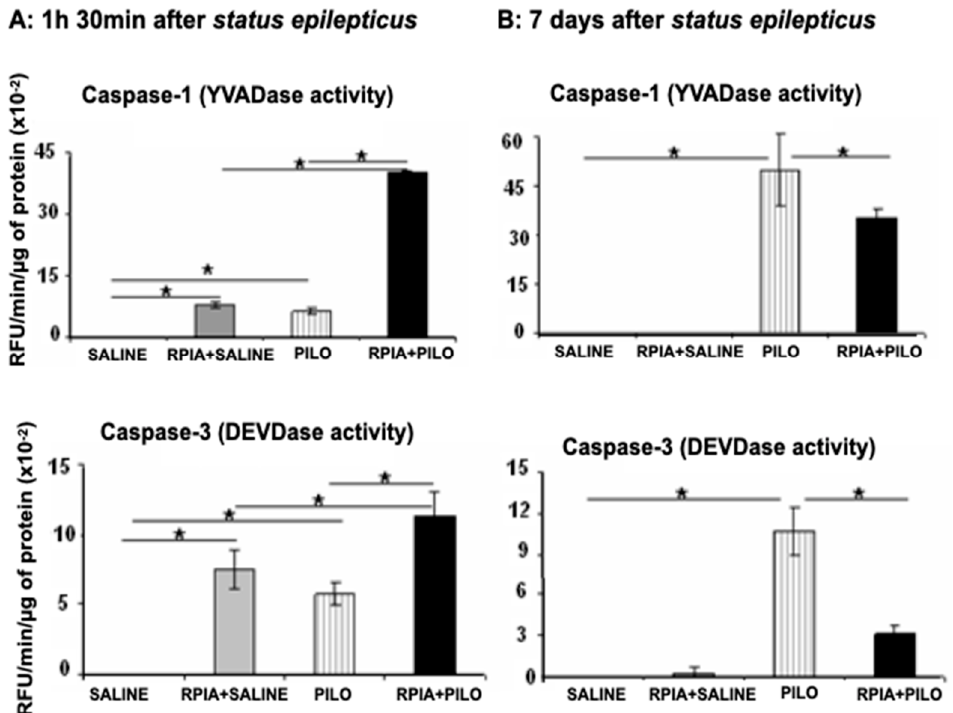
Figure 2. Fluorometric assay of caspases in the hippocampal homogenates from rats studied at various time points following pilocarpine-induced status epilepticus. R-PIA was injected 15 min before saline (R-PIA+SALINE) or pilocarpine injection (R-PIA+PILO). Significant increases in caspase-1 and -3 activity were observed in the R-PIA+SALINE, PILO, and R-PIA+PILO groups compared to PILO group ( A ). Seven days following the SE onset ( B ), there was a significant increase in the